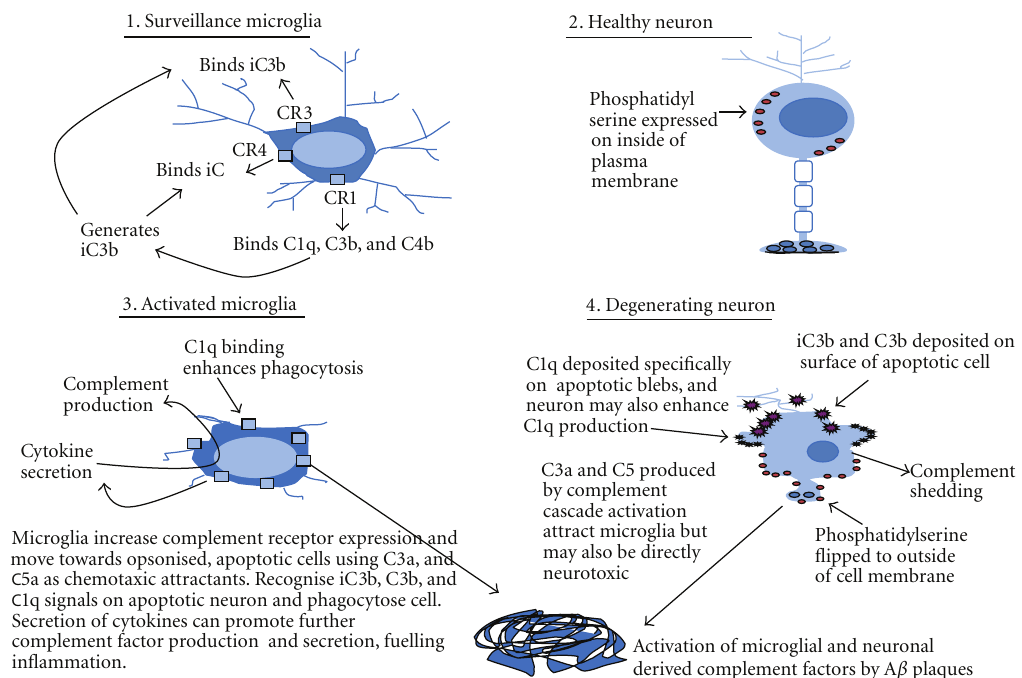
Figure 2: Interactions between microglia and neurons mediated by complement. Surveillance microglia may express low levels of CR1, CR3, and iC3b whilst healthy neurones do not express or produce significant complement. Phosphatidylserine is mainly expressed on the internal surface of the neuronal plasma membrane, preventing it acting as an “eat-me” signal, and complement production by the cell is low. During neuroinflammation and neurodegeneration, activated microglia, responding to the generation of complement factors, increase their expression of complement receptors, produce complement factors, and migrate towards the chemotaxic signals of C3a and C5a. Microglia may exacerbate the secretion of complement factors by secreting cytokines (following exposure to A β plaques), which can feed onto astrocytes or form a feedback loop with microglia themselves, promoting glial complement factors secretion. Exposure of secreted complement factors to A β plaques can lead to complement activation. Apoptotic neurones become opsonised with iC3b, C3b, and C1q deposition, the latter on apoptotic blebs, and the neurons may also shed additional complement factors. Phosphatidylserine flips to the outside of the plasma membrane where it can potentiate expression of “eat-me” signals by promoting the expression of iC3b on the cell surface